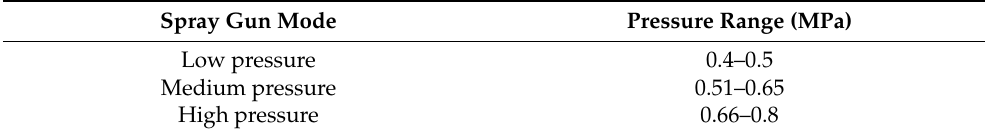
Table 3. Working pressure range for spray